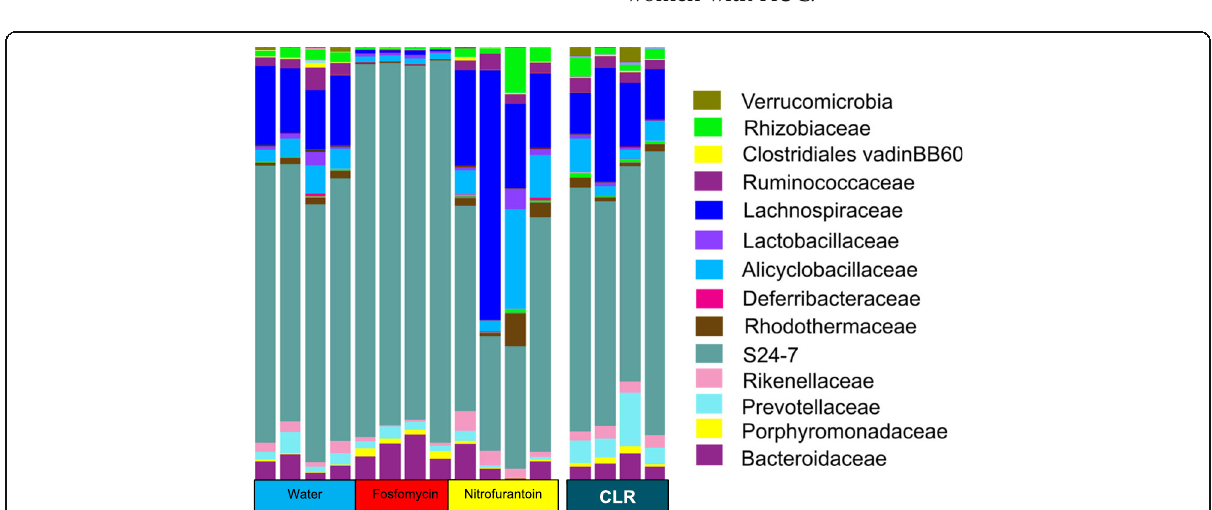
Fig. 2 Protection of microbiome with CLR in comparison to fosfomycin and nitrofurantoin after daily administration of CLR and antibiotics, respectively, by gavage in mice